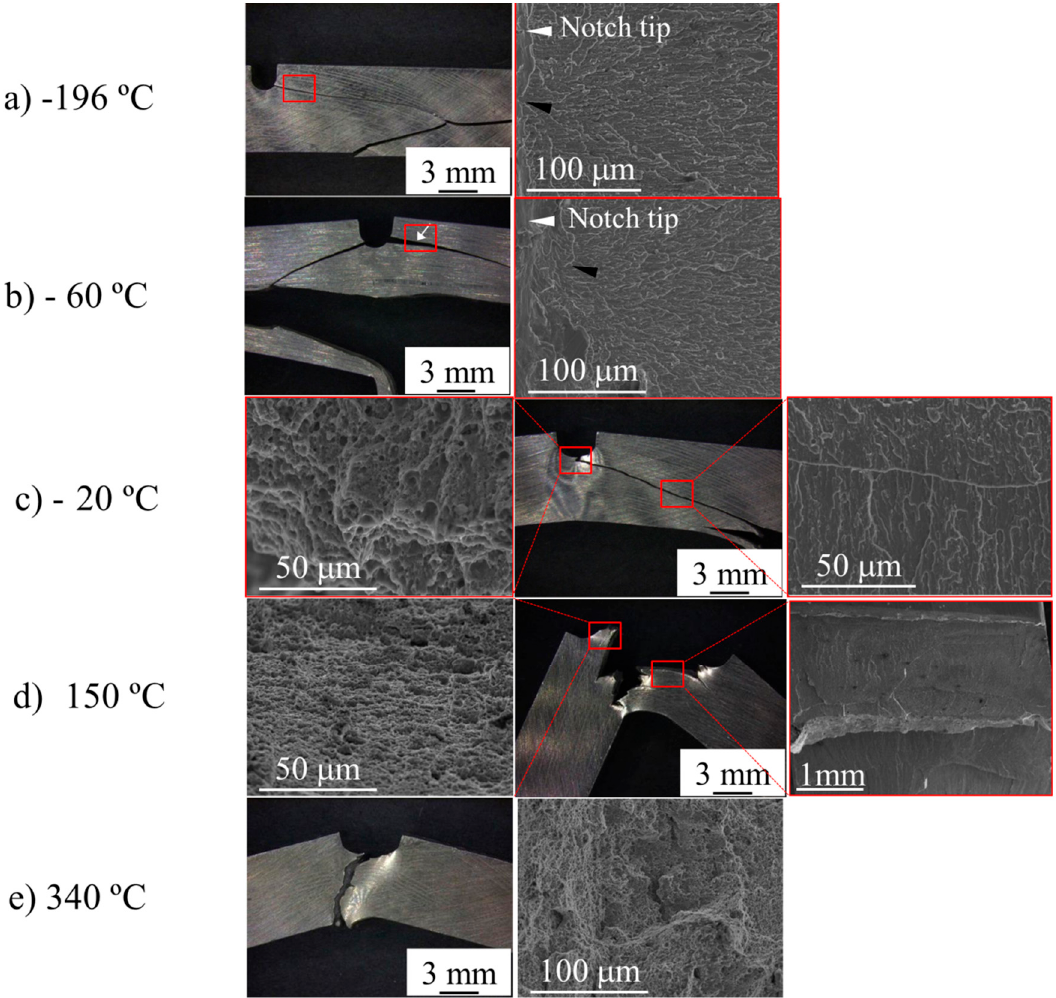
Figure 9. Appearances of LS ‐ notched Charpy impact test specimens of the PM2000 alloy after fracture at ( a ) − 196 °C; showing the fracture profile ( left ) and fracture initiation point on the fracture surface ( right ); ( b ) − 60 °C; showing the fracture profile ( left ) and fracture initiation point on the fracture surface ( right ); ( c ) − 20 °C; showing the fracture profile ( middle ), the microscopic features of stable ductile tear ( left ), and microscopic features of the fracture surface on the 70° ‐ inclined plane; ( d ) +150 °C; showing the fracture profile ( middle ), the microscopic features of stable ductile tear ( left ) and microscopic features of the fracture surface on the 70° ‐ inclined plane ( right ); ( e ) 340 °C; showing the fracture profile ( left ) and the microscopic features of the fracture surface ( right ).